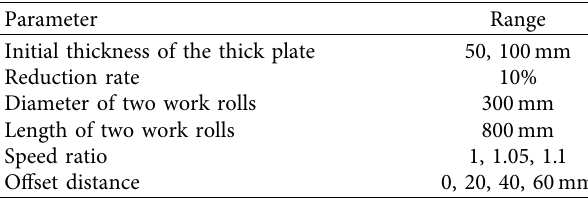
Table 1: Parameters of the geometry